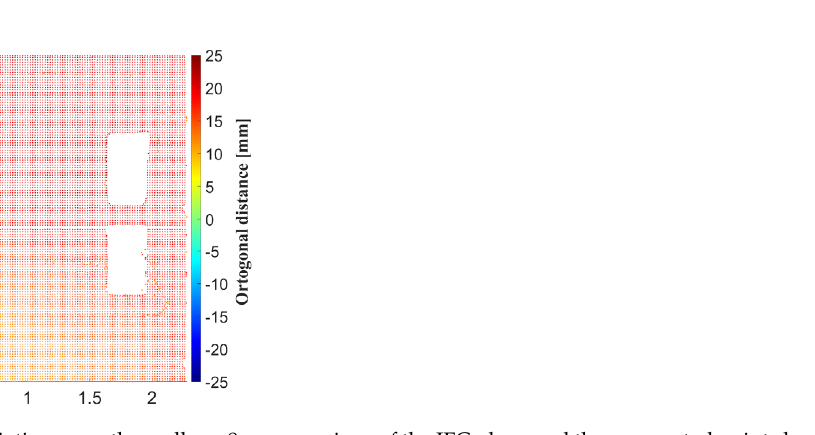
Figure 17. Deviation map, the wall no. 7—comparison of the IFC plane and the segmented point cloud.